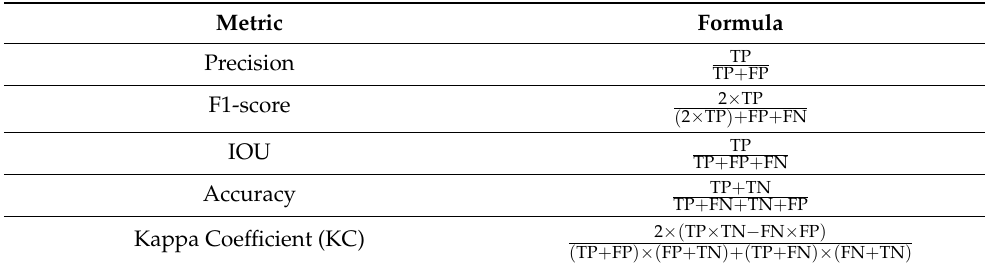
Table 4. Information formulas for accuracy assessment